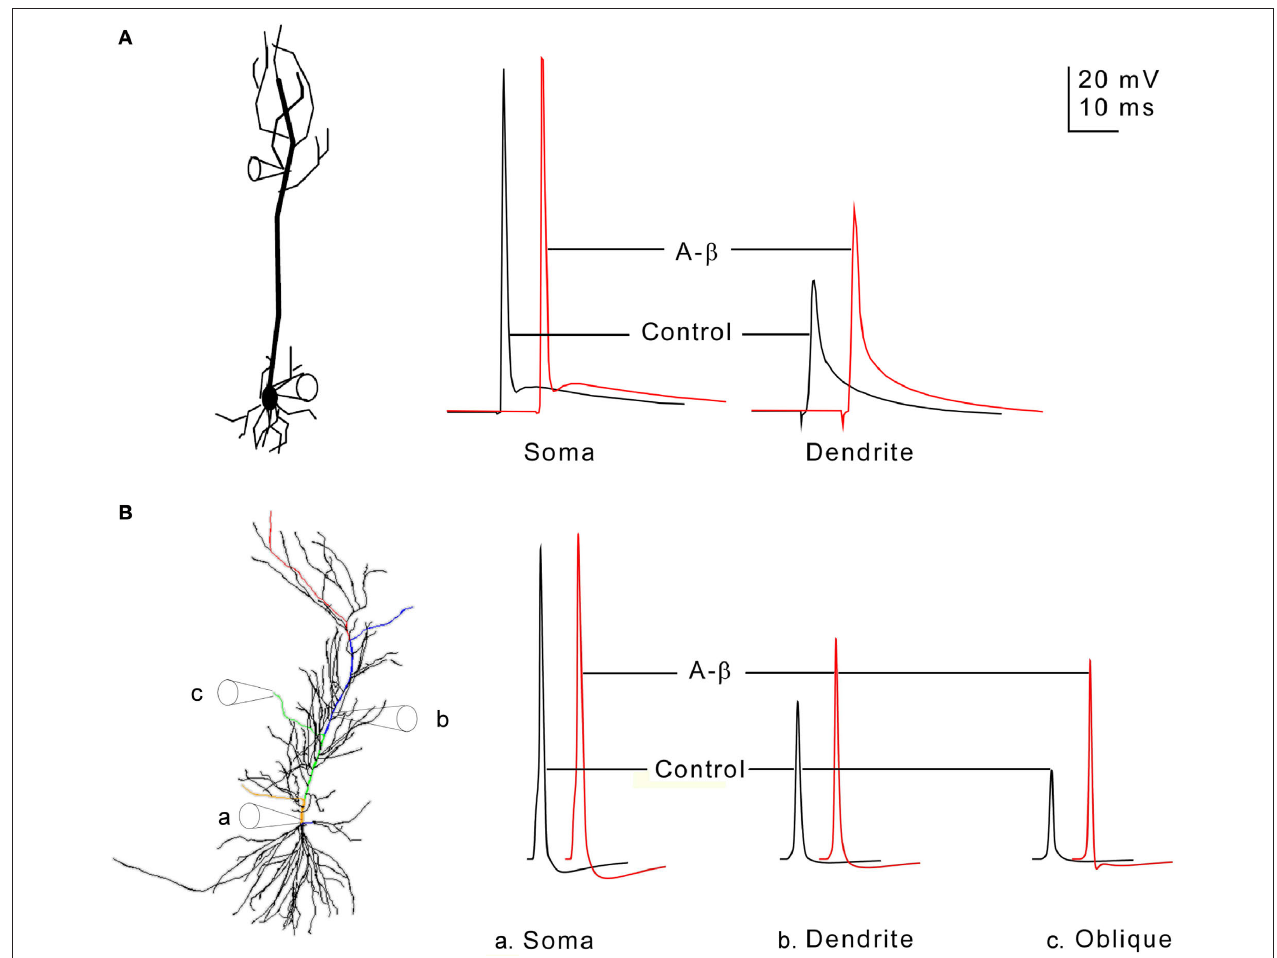
Figure 1 | (A) Identified CA1 neuron with soma and primary dendritic spike recordings (modified from Chen, 2005 to transform recordings to the same scale bars); red color indicates the a β applied condition. The voltage traces were recorded at the soma and the primary dendrite 280 μms from the soma. (B) . Morphology and simulated recordings from our CA1 pyramidal neuron model.